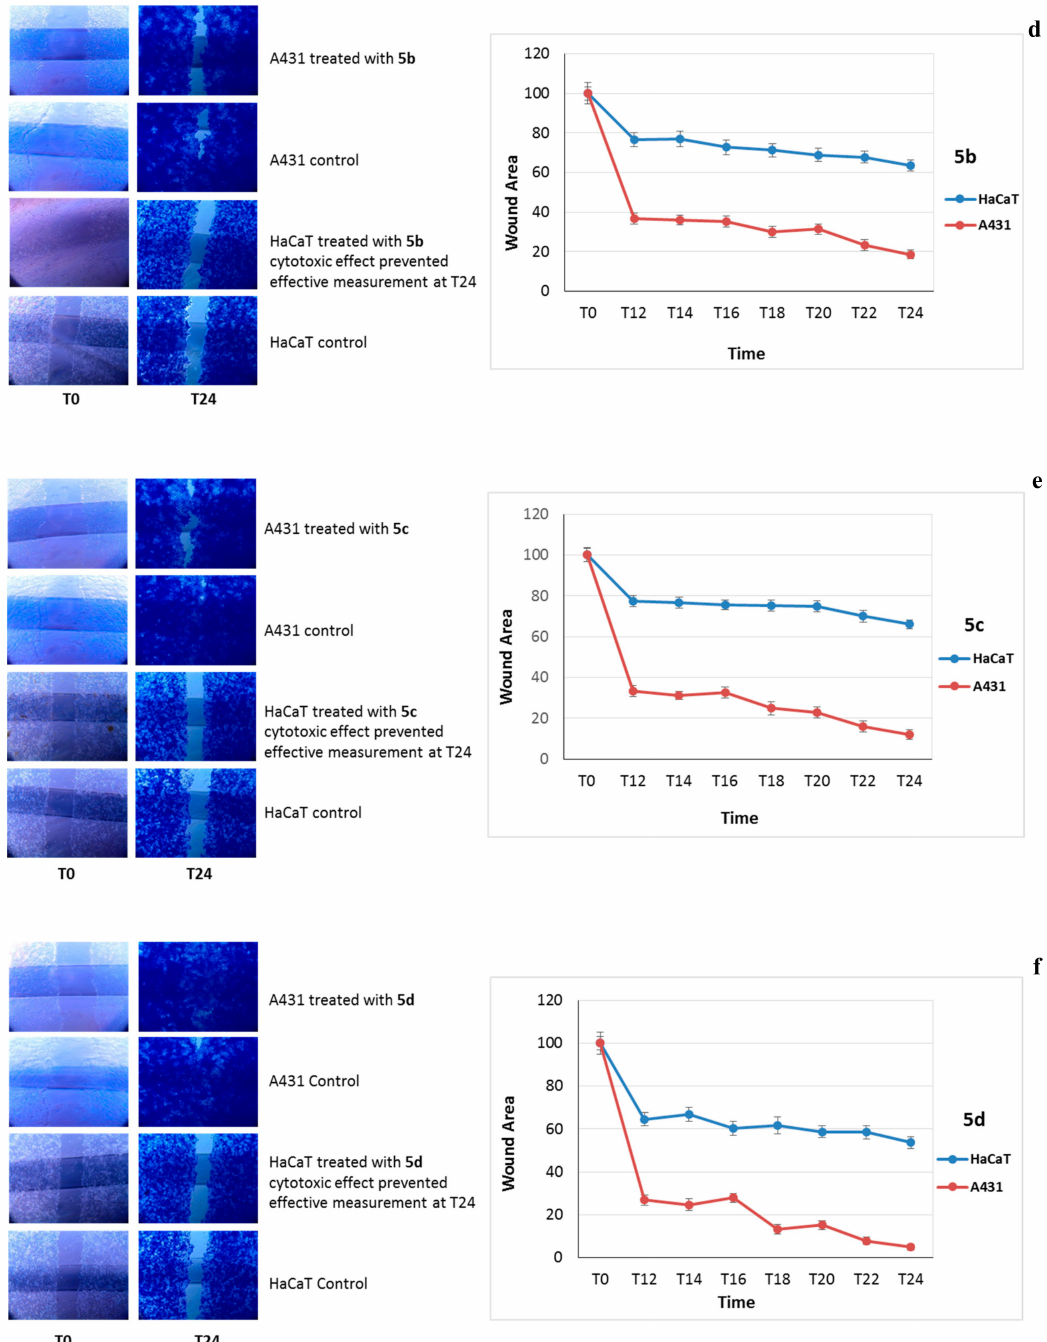
Figure 4. The e ff ect of compounds ( a ) 3e , ( b ) 3h , ( c ) 5a, ( d ) 5b , ( e ) 5c , and (f) 5d on cell migration of cancerous A431 vs. noncancerous HaCaT